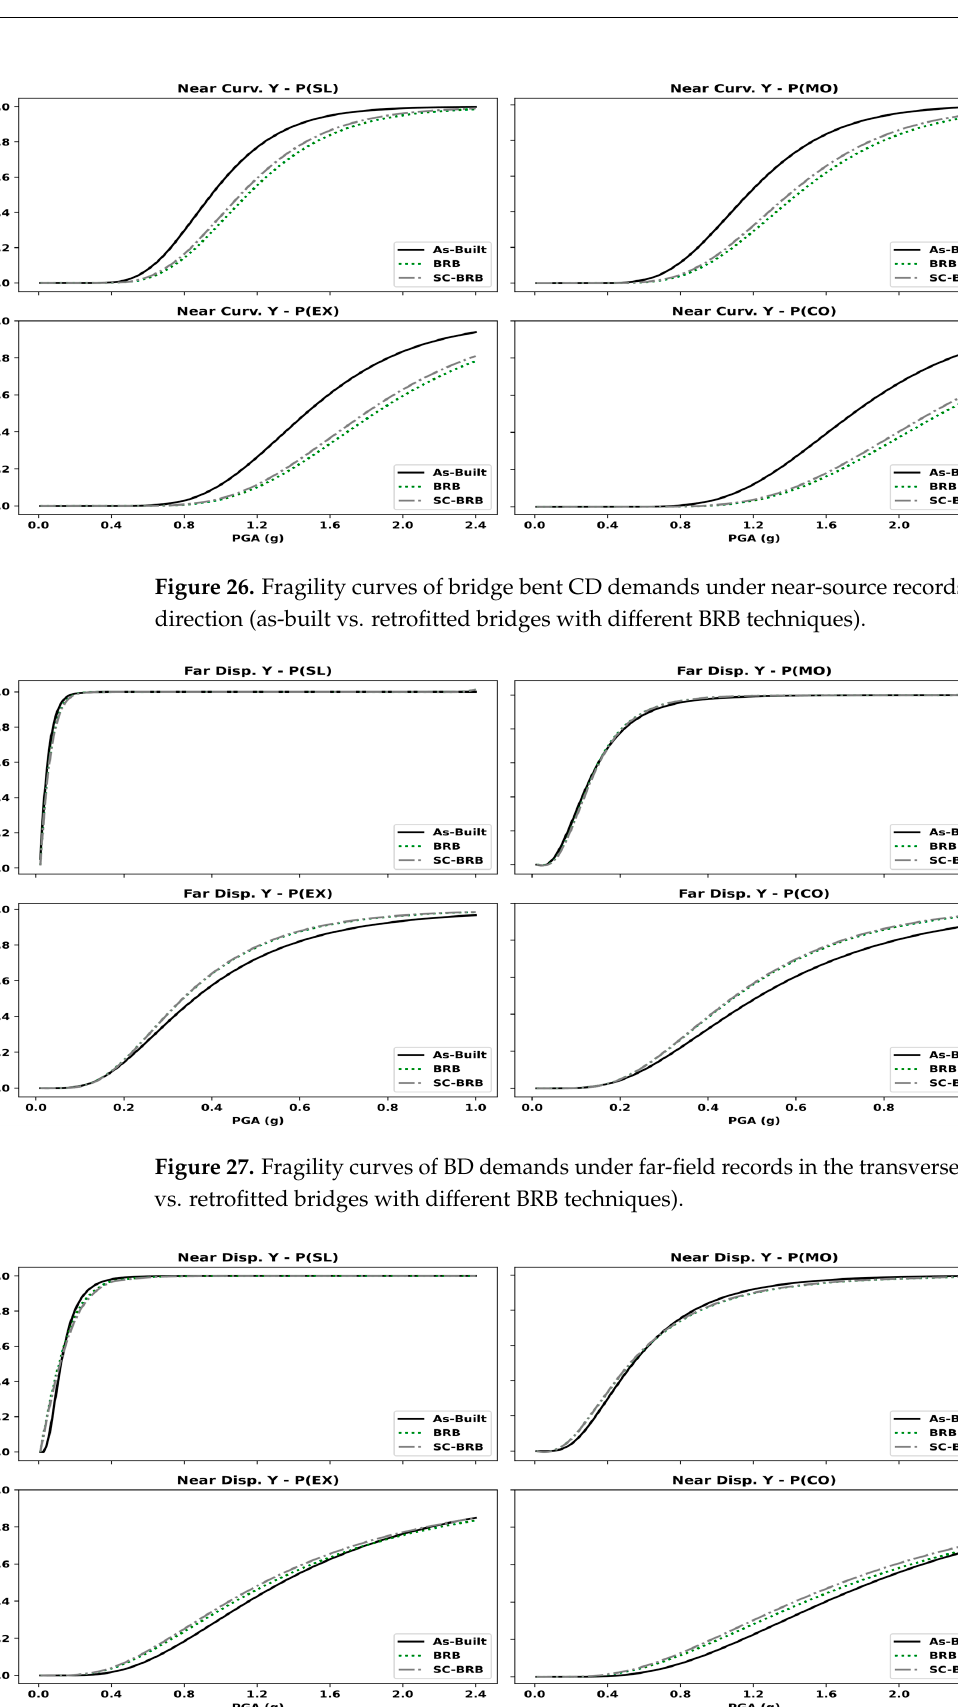
Figure 28. Fragility curves of BD demands under near-source records in the transverse direction (as-built vs. retrofitted bridges with different BRB techniques).